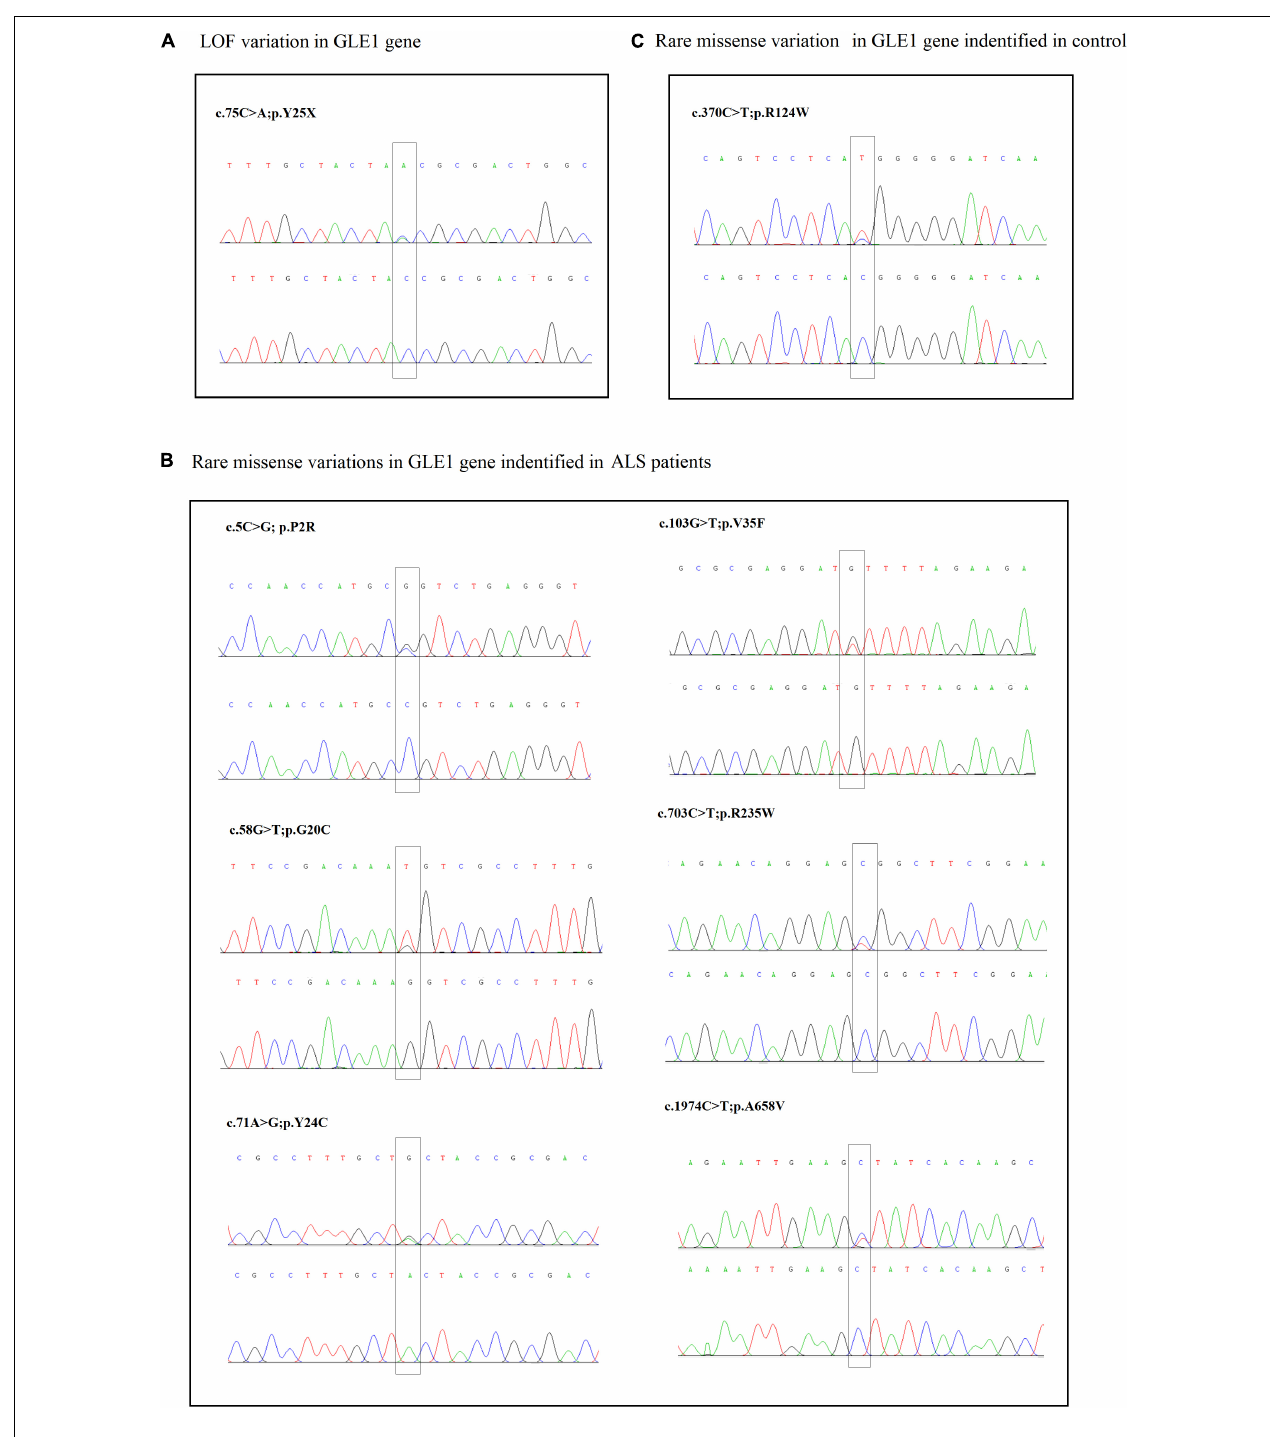
FIGURE 1 | (A) The sanger sequencing of the LOF variant identified in sALS patients. (B) The sanger sequencing of the rare missense variants identified in sALS patients. (C) The sanger sequencing of the rare missense variants identified in control.